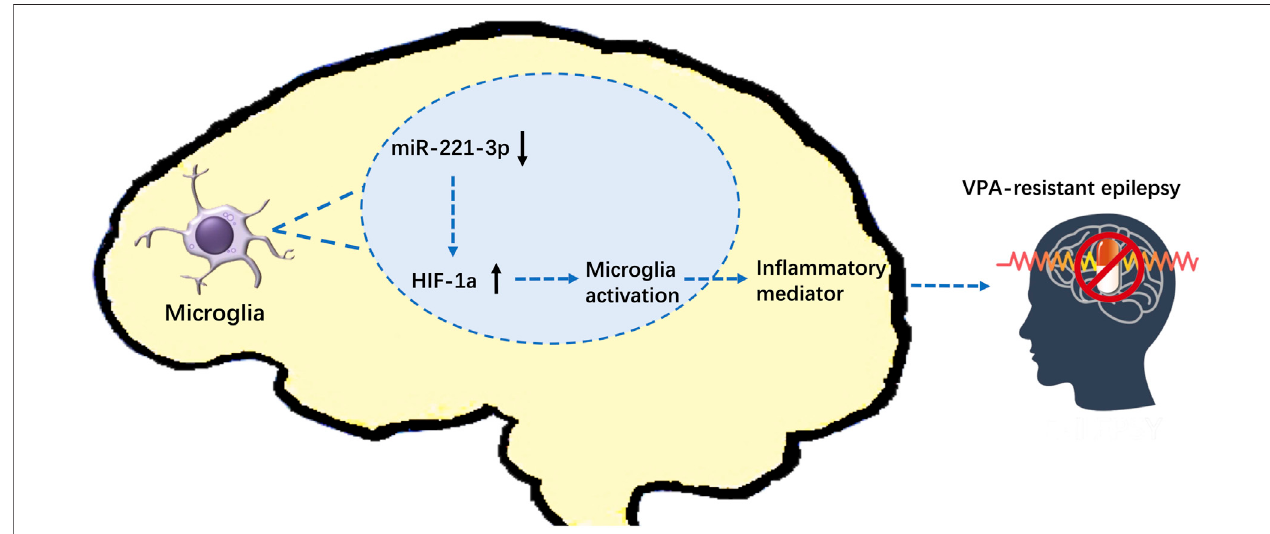
FIGURE 8 | Effect of miR-221-3p/HIF-1 α on VPA-resistant epilepsy (schematic). MiR-221-3p is downregulated in VPA-resistant epilepsy, which leads to the increase of its target gene: HIF-1 α . Increased expression of HIF-1 α activates microglia to release proin fl ammatory mediators, which exacerbates seizures of VPA- resistant